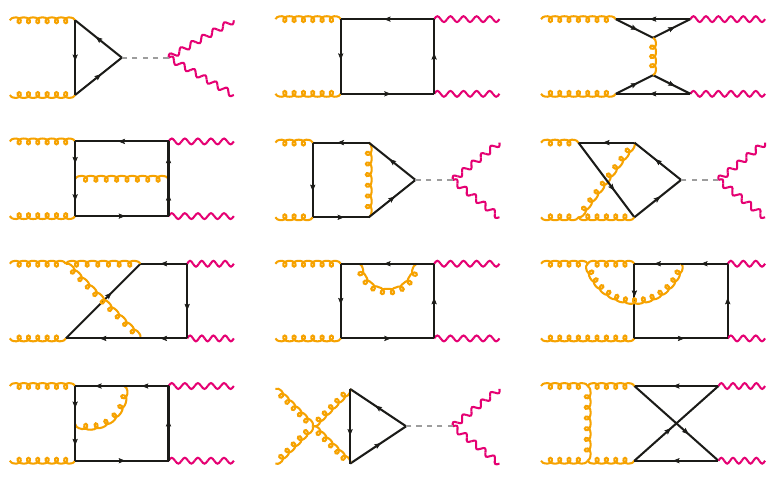
ZZ . \Double triangle" diagrams !